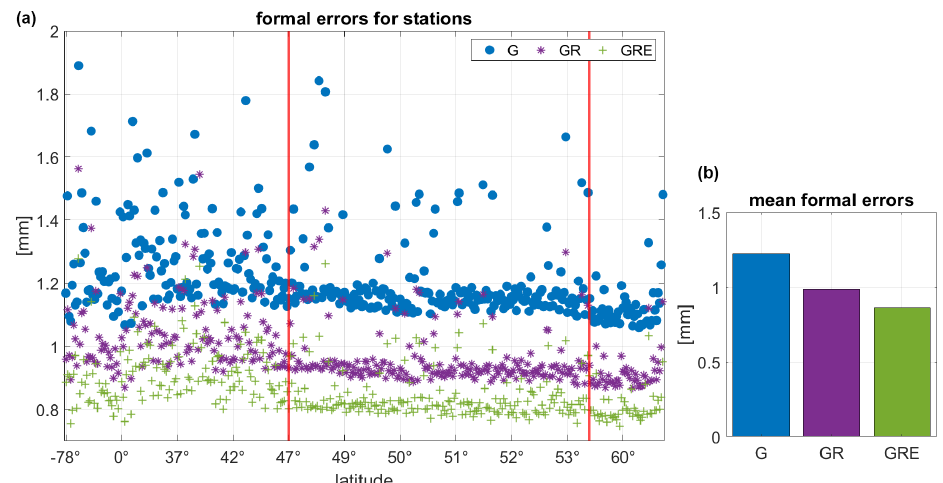
Figure 3. Average formal errors of ZTD for each station in the processing (sorted by latitude, Southern Hemisphere first) (a) and the mean formal error averaged from all stations and epochs (b) . The red lines indicate the latitude band that includes Germany. Please note that the labeling of the x axis is non-equidistant. The values are calculated for the year 2020.